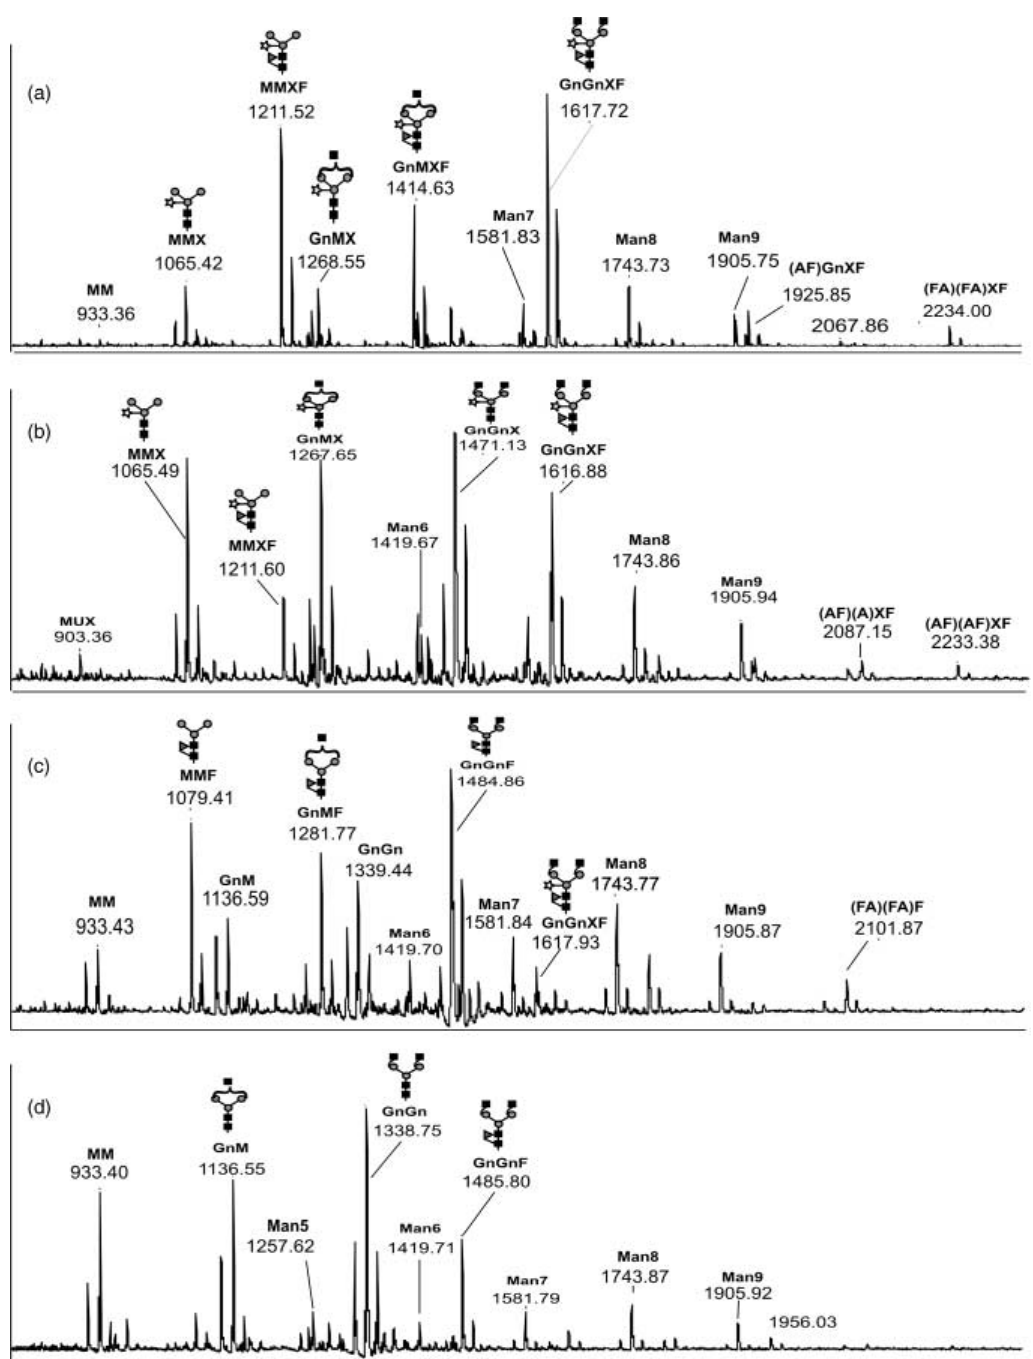
Figure 2 Matrix-assisted laser desorption ionization-time of flight/time of flight mass spectrometry (MALDI-TOF/TOF MS) of oligosaccharides from endogenous proteins extracted from Nicotiana benthamiana leaves: (a) wild-type; (b) ∆ FT; (c) ∆ XT; (d) ∆ XT/FT. The labelled peaks represent (M + Na) + ions. Other peaks are potassium adducts of the same glycans. (See http://www.proglycan.com for an explanation of N -glycan